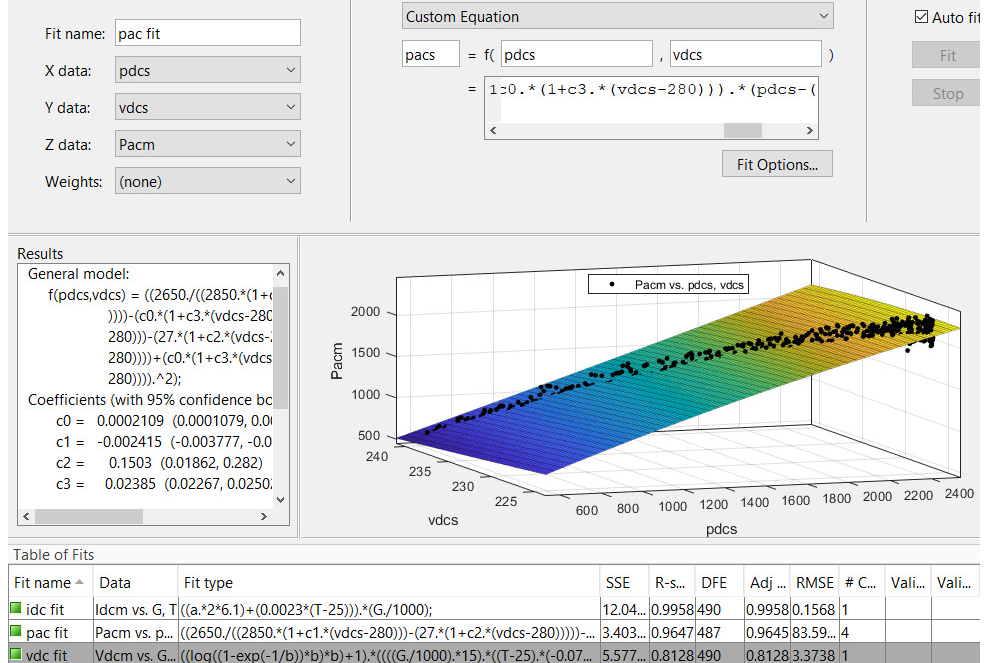
Figure 5. Parameters identification under MATLAB using curve fitting